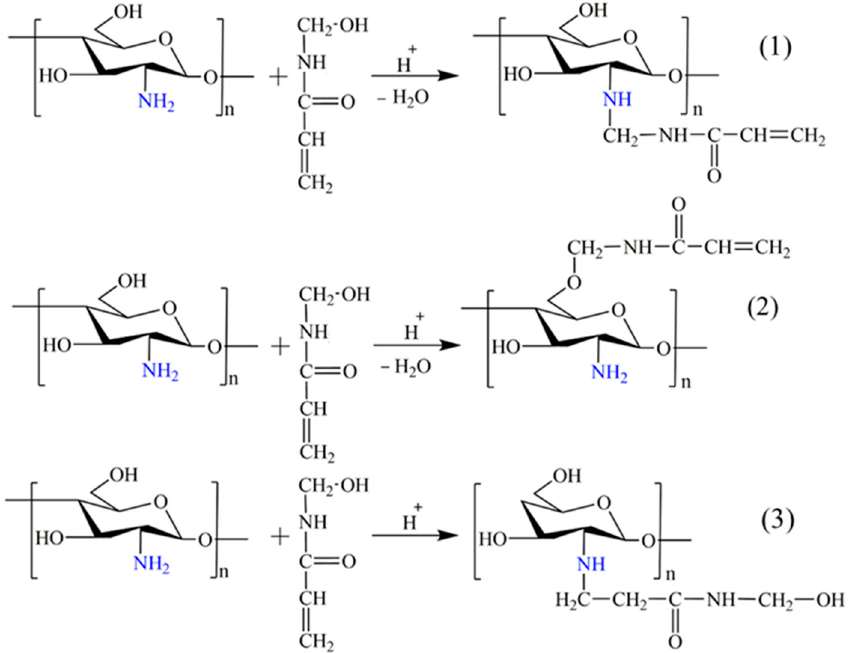
Figure 4. Proposed scheme of chitosan interaction with NMA hydroxymethyl groups (1, 2); NMA vinyl groups (3).